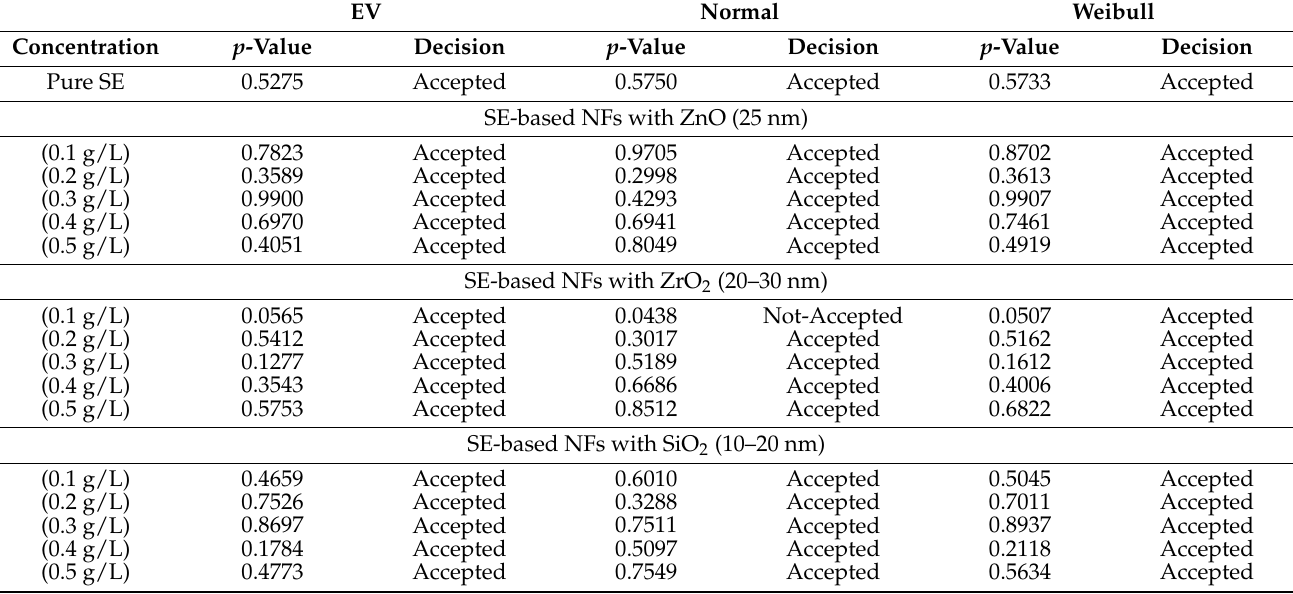
Table 6. Hypothesis test of conformity of breakdown voltage outcomes of various nanofluids to EV, Normal, and Weibull distributions considering p -value calculation, for 2.5 mm electrode gaps.